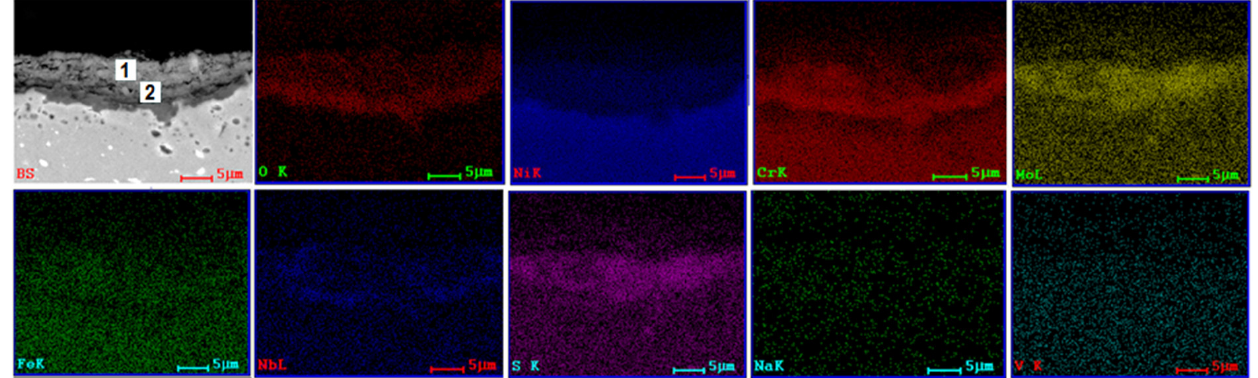
Figure 4. SEM image (backscattering mode, BS) and EDS distribution maps of the elements corre- sponding to SEM image for cross section of AP (900 °C, 96 h).